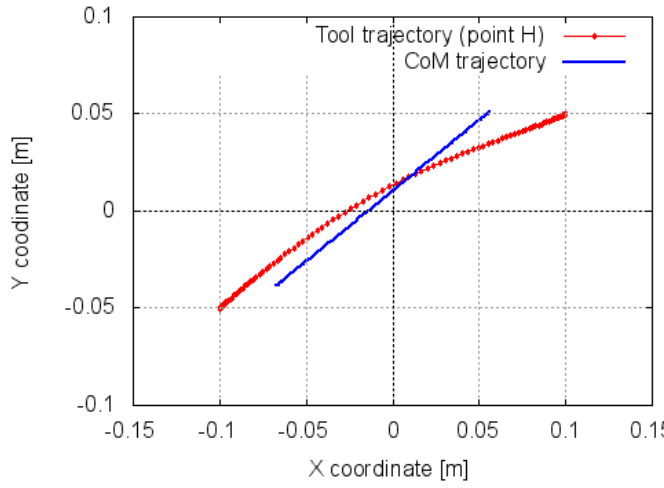
Figure 6. The tool trajectory (point H ) after guiding the global CoM with a “bang-bang” profile.